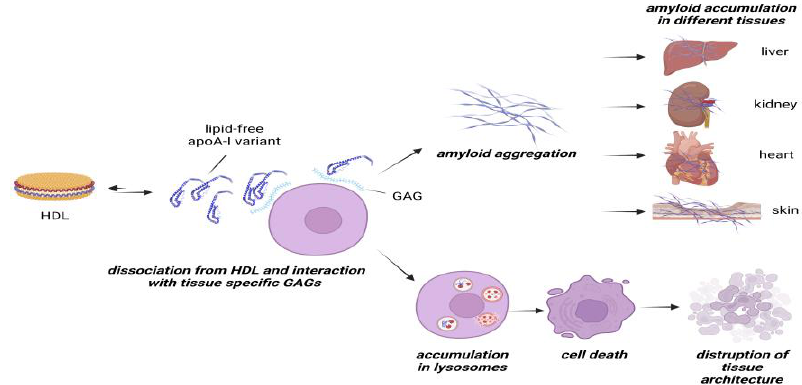
Figure 7. Proposed mechanism behind ApoA-I amyloidogenic variants cytotoxicity and preferential organ accumulation. ApoA-I proteins in circulation exist in two forms in equilibrium, lipid-free and the preferred lipid-bound state (HDL). In the case of amyloidogenic variants (depicted as the blue protein), this equilibrium is shifted towards the less structurally stable lipid-free form. The interaction of the lipid-free variants with tissue-specific GAGs leads to two consequences: (1) it promotes protein misfolding and amyloid aggregation, eventually resulting in fibrils accumulation in that tissue; (2) it promotes protein internalization in target cells, where the misfolded variants are redirected to lysosome and hamper lysosomal functionality, resulting in cell death and consequent disruption of tissue architecture. The figure has been created with BioRender.com, accessed on 21 September